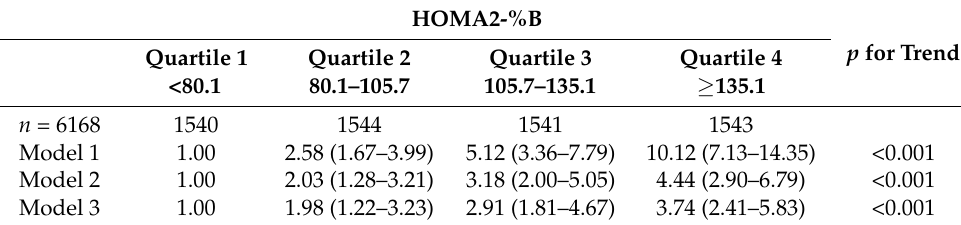
Table 3. Adjusted odds ratios (95% confidence intervals) of presence of moderate to severe hepatic steatosis according to HOMA2-B% quartiles using logistic